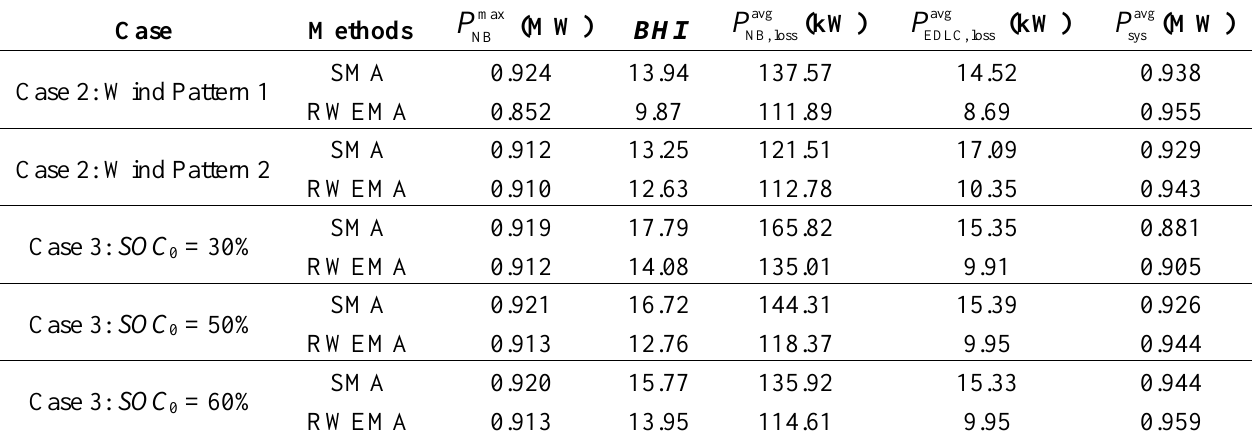
Table 4. Comparison between SMA and RWEMA for Cases 2 and 3. BHI : battery health